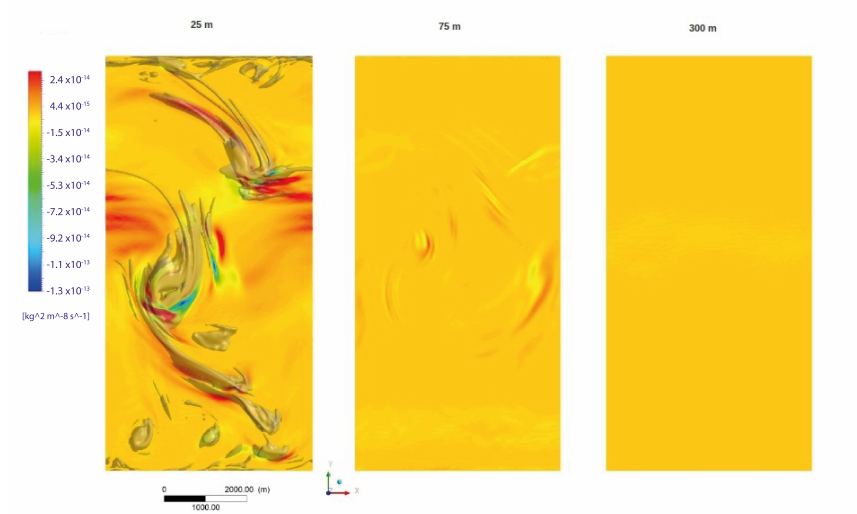
Figure 10. The frontogenesis factor at the depths of 25 m ( left ), 75 m ( middle ), and 300 m ( right ). The Ro = 1 isosurface projection is shown as a grey